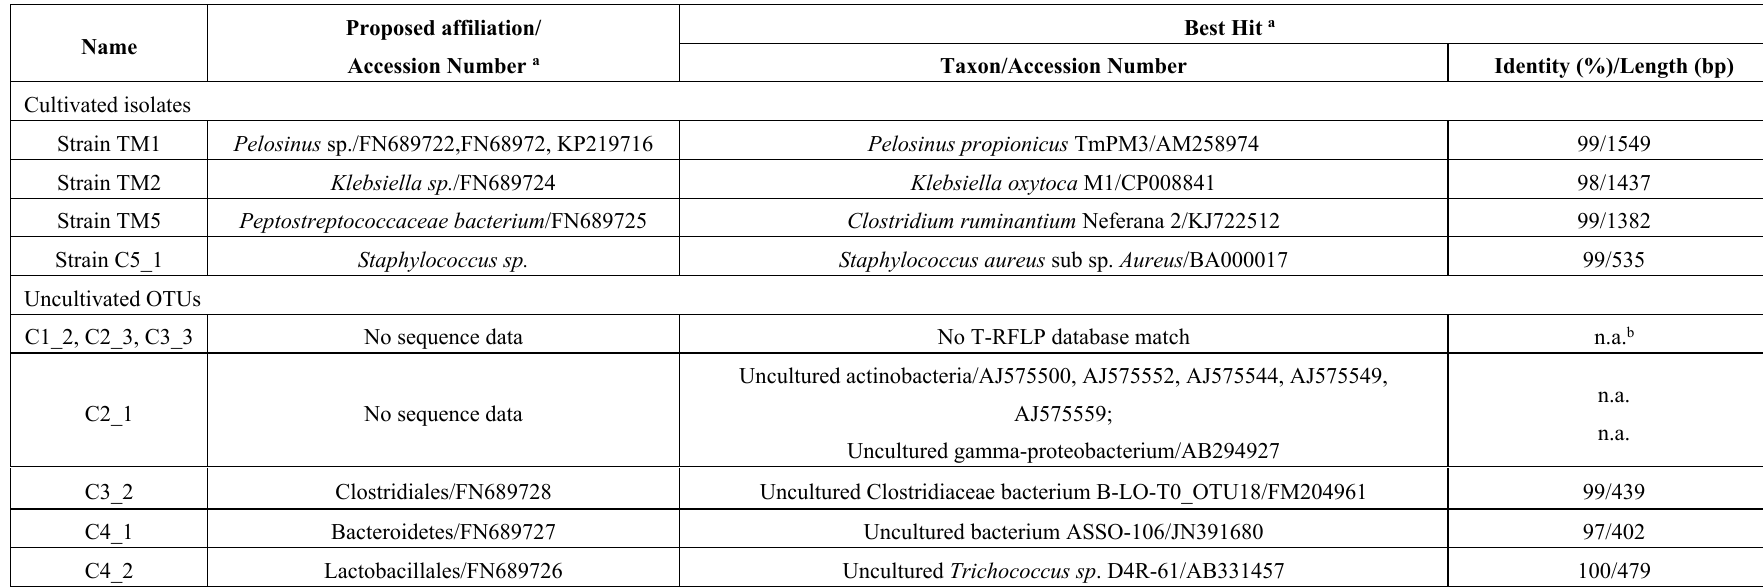
Table 1. 16S rRNA-based taxonomic affiliation of bacterial strains in CCl 4 -degrading